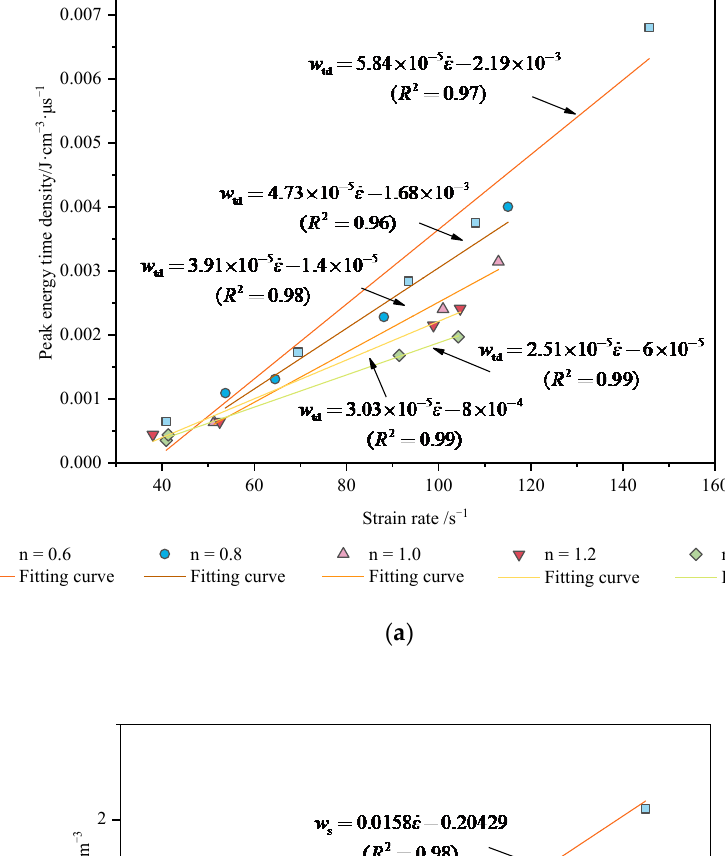
n = 1.4 Fitting curve